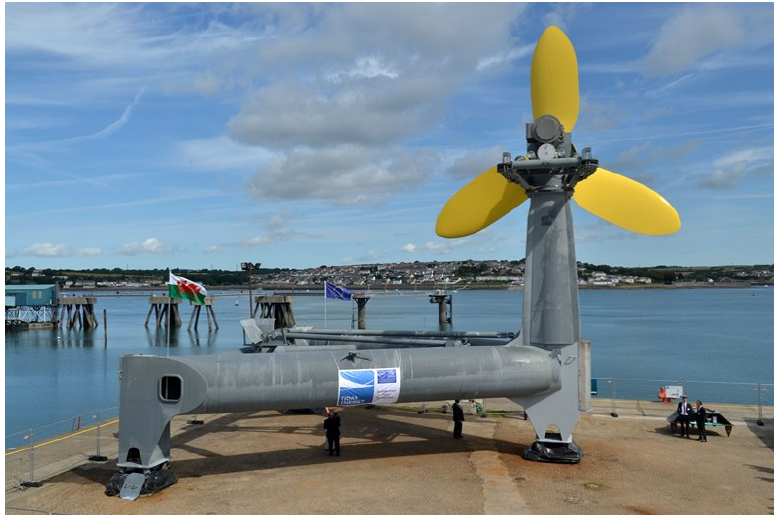
Figure 3. Full-scale tidal turbine on the quayside ahead of its installation at Ramsey Sound